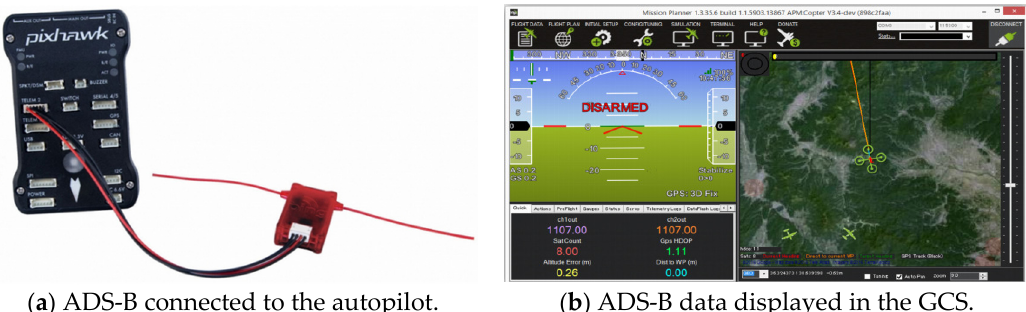
Figure 15. The pingRX ADS-B dual receiver from uAvionix was directly connected to the drone’s autopilot.